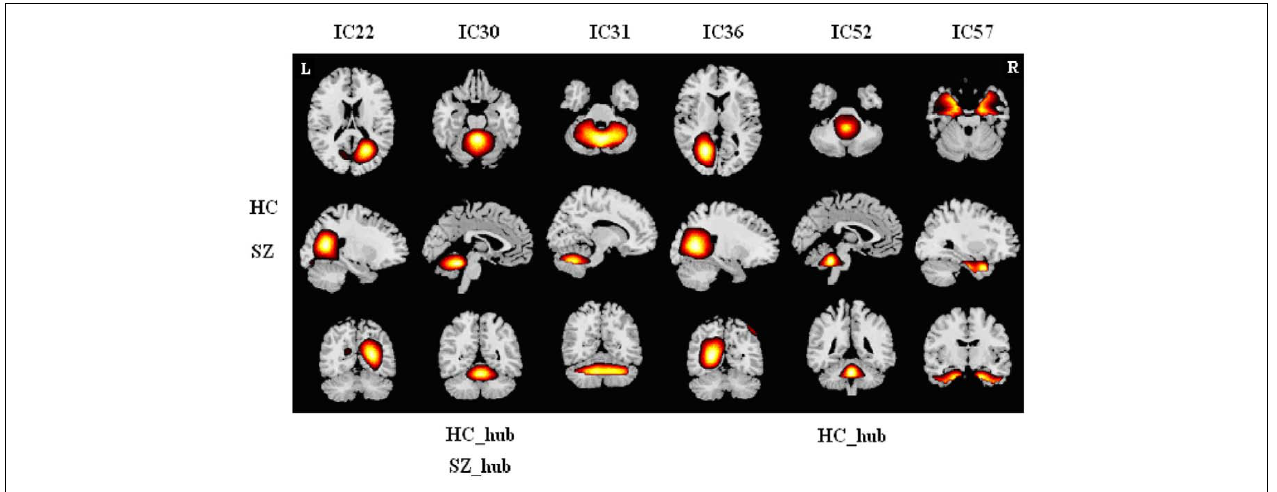
including three cerebellar networks, two occipital networks, and one temporal network.We designated this module as “cerebellar–occipital module” (C–O Module).Two cerebellar components are hubs in HCs and one cerebellar component is hub in